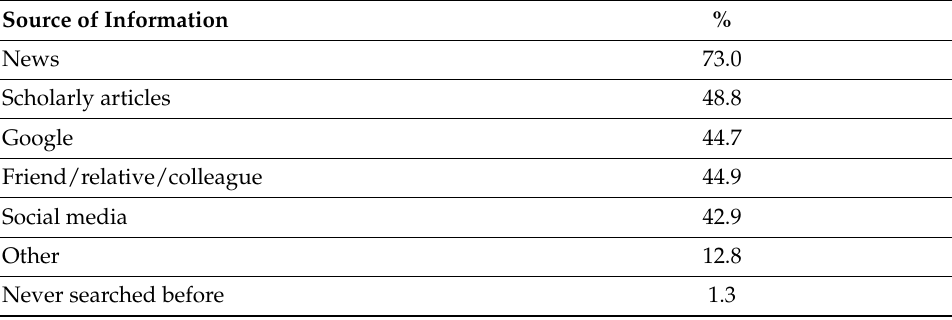
Table 2. Source of information regarding plastic consumption and health.